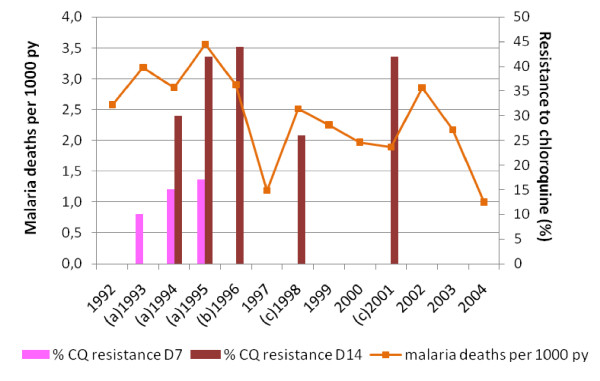
Evolution of malaria mortality and resistance to chloroquine between 1992 and 2004 in Niakhar area. The orange line represents the malaria mortality per 1,000 person-year (py) in the population. Red bars represent the rate of chloroquine resistance (%) measured at day 14 after treatment by chloroquine. Pink bars represent the rate of chloroquine resistance (%) measured at day 7 after treatment by chloroquine. (a) 1993, 1994, 1995: in vivo chemosensitivity studies, Diohine village, Niakhar DSS [5]. (b) 1996: in vivo chemosensitivity study, Diohine village, Niakhar DSS [7]. (c) 1998 and 2001: in vivo chemosensitivity studies, Kaolack sentinel site, 50 km from Fatick [8].